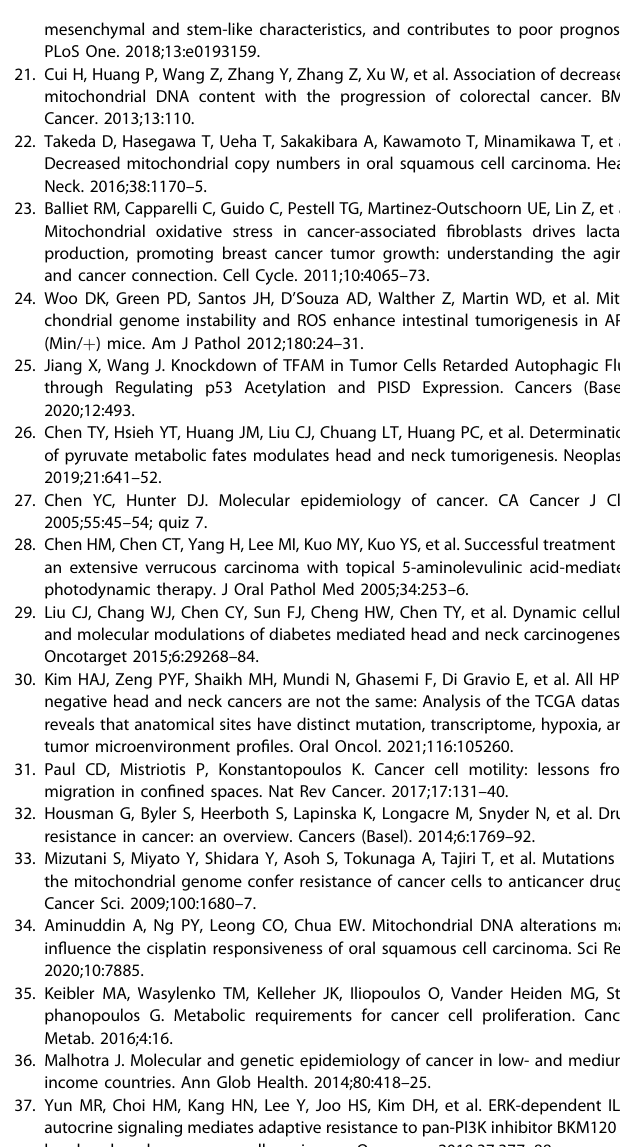
Fig. 7 Decreasing TFAM/mtDNA contributes HNC pathogenesis. mtDNA encoded gene expression declines during HNC initiation. Further loss of TFAM/mtDNA triggers HNC malignant progression via multifaceted metabolic and molecular